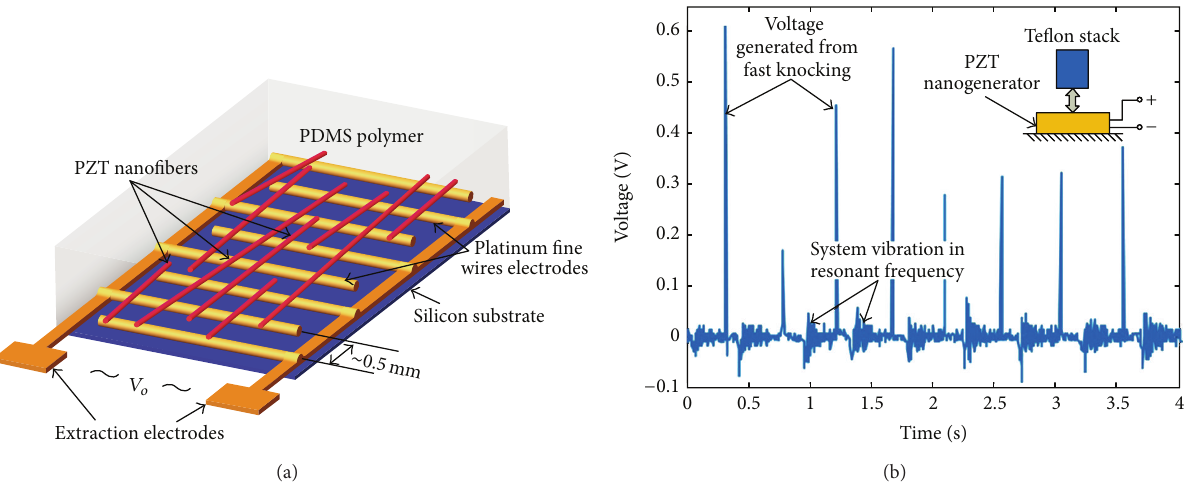
Figure 10: The PZT nanofiber-based LING (a) and the generated open-circuit voltage (b). (Reproduced from [43] with the permission from American Chemical